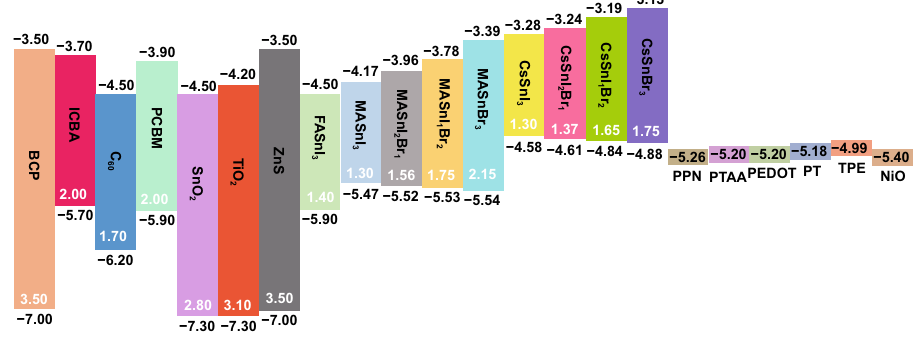
Fig. 5 Energy diagram of common Sn-based perovskites, ETLs and HTLs. Unit: